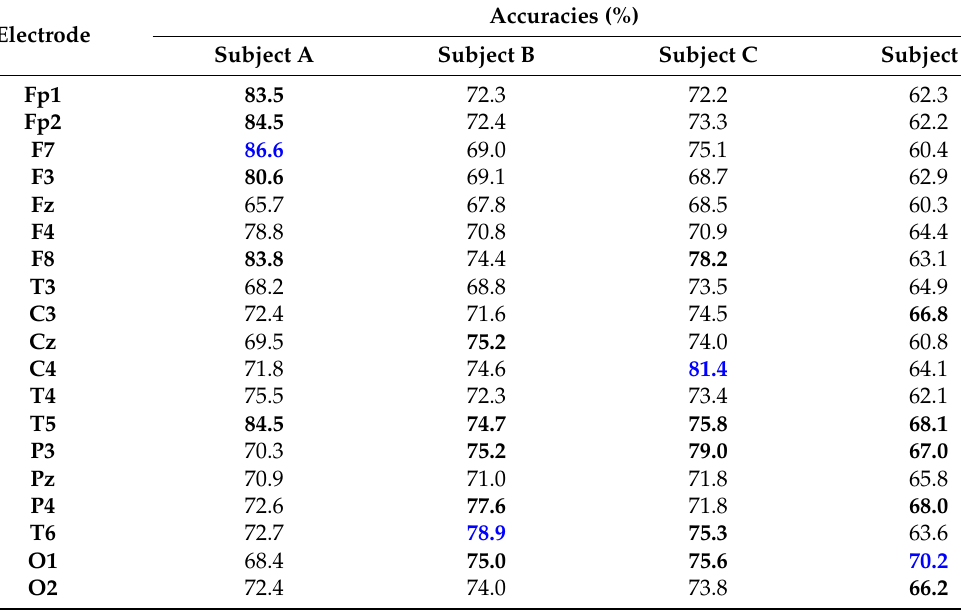
Table 4. Classification accuracies achieved for each electrode